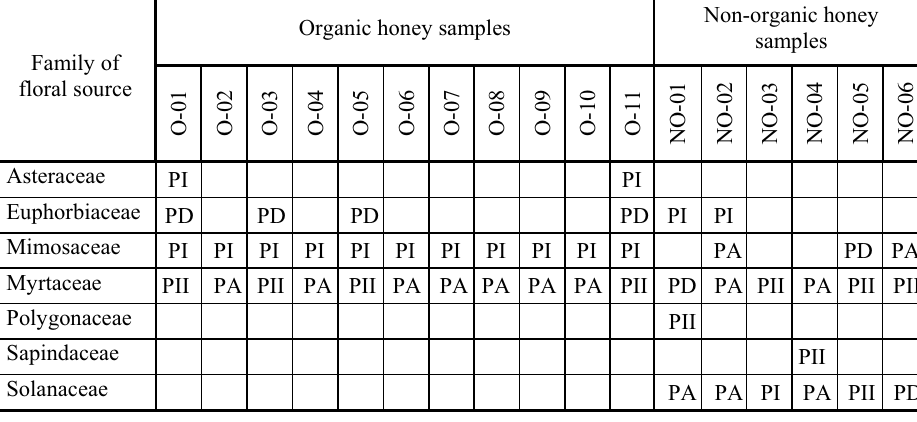
Pollen spectra of organic and non-organic honey samples of A. mellifera after quantitative and qualitative analyses of pollen